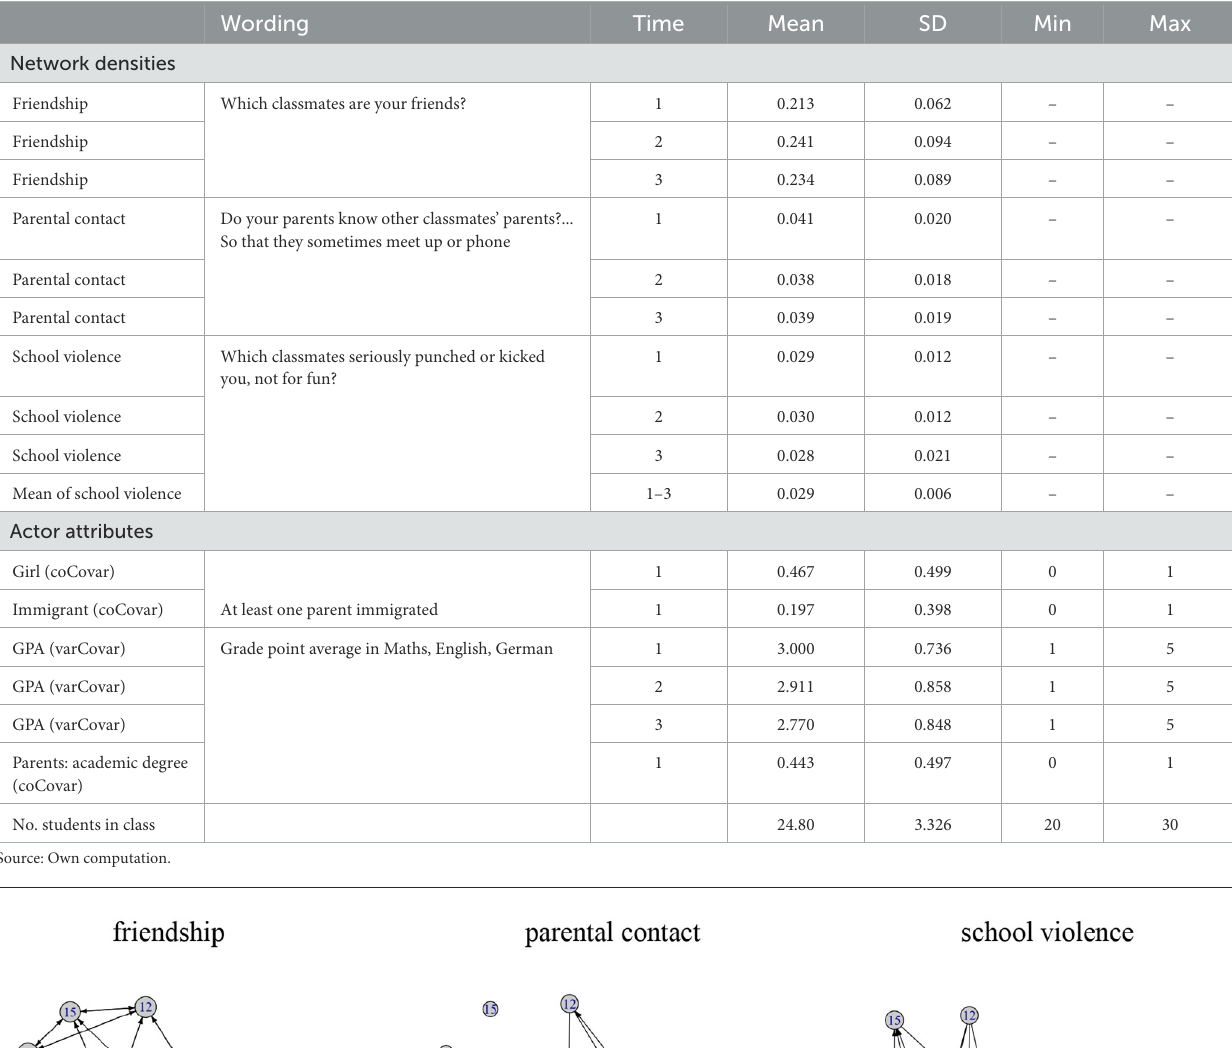
TABLE 1 Descriptive statistics, of k = 10 classes, N = 248 students.